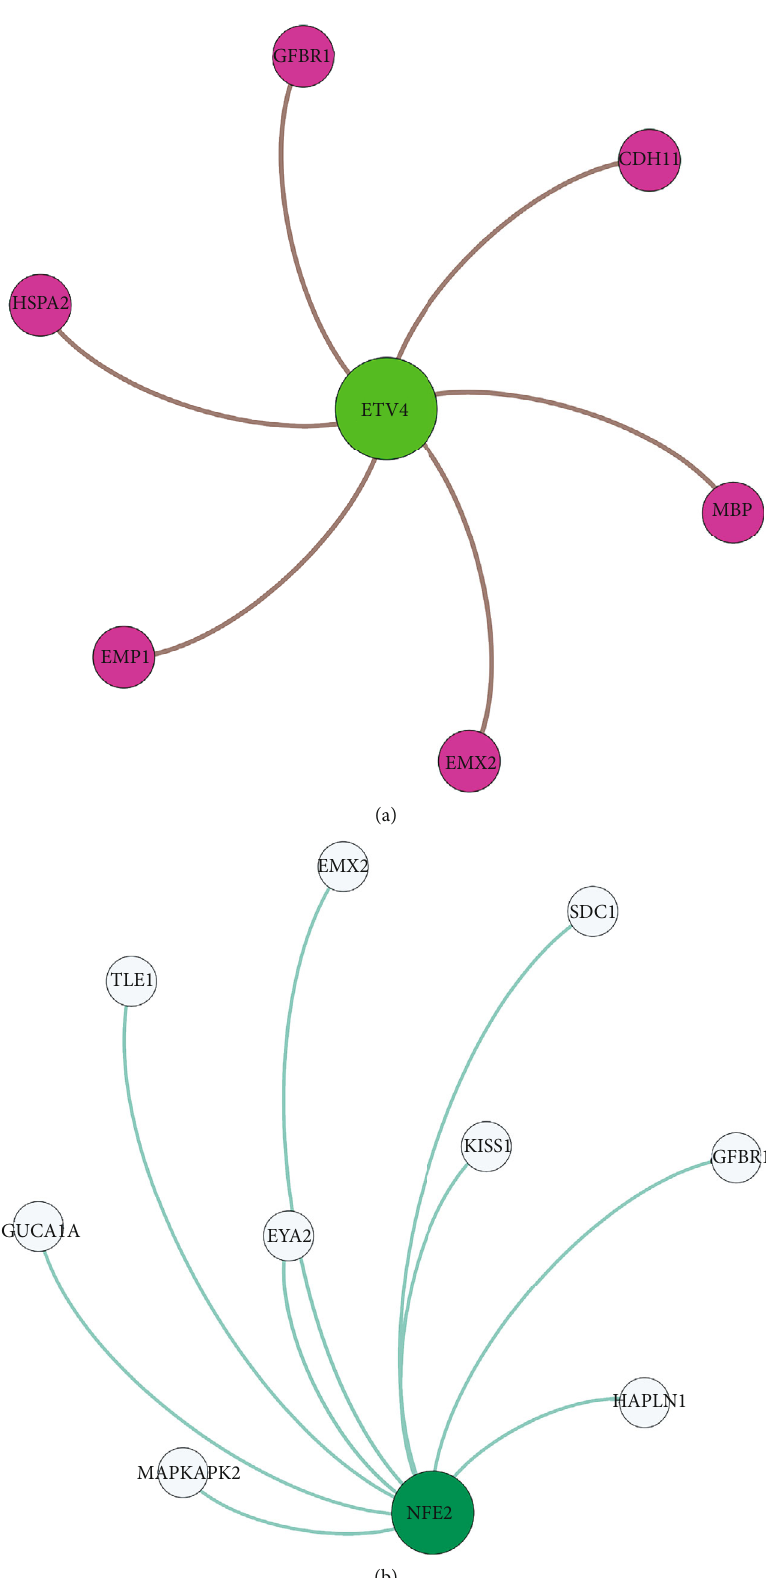
Figure 5: Targeted transcript factor prediction of the DEGs in the MAKP signaling pathway. They were ETV4 and NPE2. ETV4 may target TGFBR1, HSPA2, EMP1, EMX2, MBP, and CDH11. NPE2 may target MAPKAPK3, GUCA1A, TLE1, EYA2, EMX2, SDC1, KISS1, TGFBR1, and